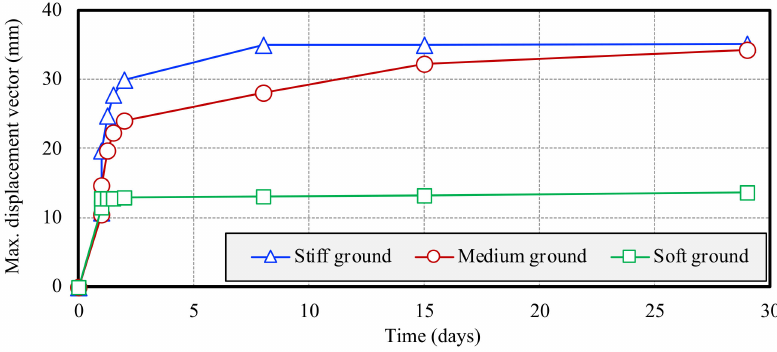
Figure 3. Rates of change in maximum displacement vectors for single boreholes left